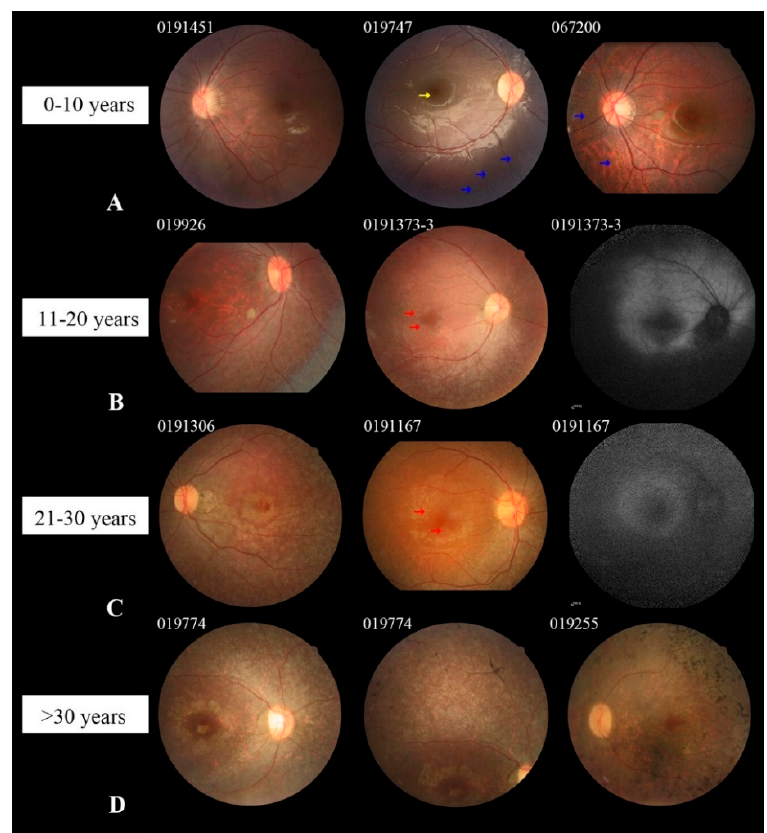
Figure 3. Colored fundus (CF) and fundus autofluorescence (FAF) photographs of patients with RPE65-IRD. ( A ) CF photographs of three patients in group 1 show tapetoretinal degeneration (TD), white dots (WD, marked by blue arrows) in the mid-peripheral retina, and yellowish granular dots (yellow arrows) in the fovea. CF image of patient 067200 displays diffuse WD with a leopard fundus. ( B ) CF photographs of patients in group 2 show obvious TD and macular atrophy, and the epiretinal membrane in the macula (red arrow). FAF of patient 0191373-3 displays extensive hypo-autofluorescence and a parafoveal hyper-autofluorescence ring. ( C ) CF and FAF images of patients in group 3 showed extensive chorioretinal atrophy. ( D ) CF photographs of patients in group 4 presented with severe and extensive TD, macular atrophy, and bone-spicule-like pigment deposits.